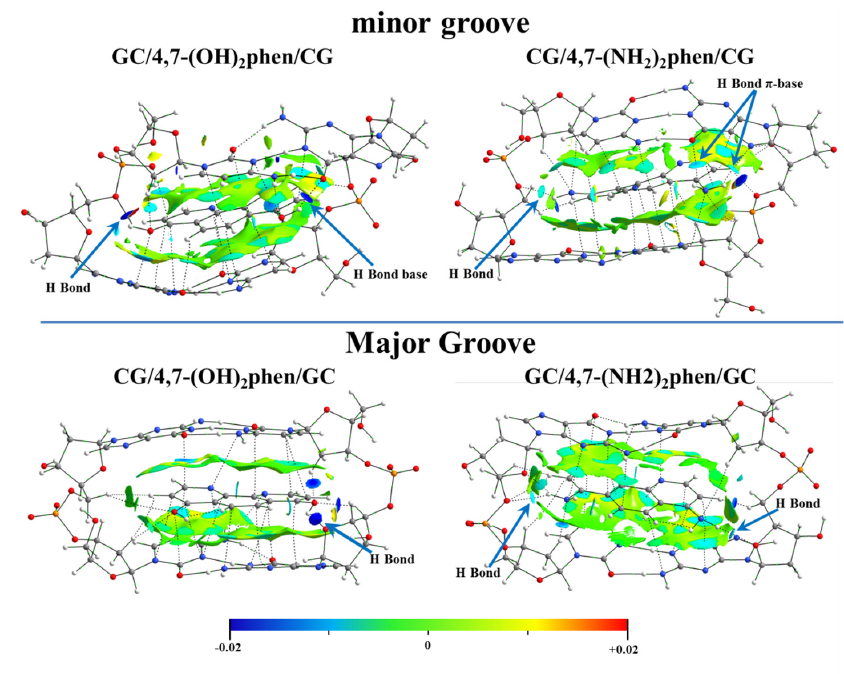
Figure 21. NCI isosurfaces for 4,7-(OH) 2 phen and 4,7-(NH 2 ) 2 phen ligands intercalated in GCCG bps through the mg and via MG, by considering ring models, at M06-2X/6-31+G(d,p) level. The NCI analysis also helped to compare the two considered intercalators, 4,7- (OH) 2 phen and 4,7-(NH 2 ) 2 phen, the main difference being that the -OH groups tended to form stronger hydrogen bonds (more negative value for the NCI index) with the O atoms of the sugar and phosphate backbone than the -NH 2 groups, even though -NH 2 groups could form two bonds. 3.4. Solvent Effects in the Interaction The solvent effects were studied for the intercalation of phen, 4,7-O 2 phen, 5,6- O 2 phen, 4,7-(NH 2 ) 2 phen and 4,7-(OH) 2 phen in ATTA and GCCG bps and for the interca- lation of 4-Mephen, 5-Mephen, 4,7-Me 2 phen, 5,6-Me 2 phen and 3,4,7,8-Me 4 phen in GCCG bps by means of a continuum model with the COSMO approach. Ref. [87] We observed in all the analyzed cases that, as a general trend, the ∆ E Solv solvation penalty (defined as ∆ E Solv = E Solv (total system) − [ E Solv (intercalator) + E Solv (pocket)]) ranged from 6.1 kcal mol − 1 for the 4,7-(NH 2 ) 2 phen ligand to 26.8 kcal mol − 1 for the 4,7-(OH) 2 phen ligand the former inter- calating in the ATTA bps via mg and the latter intercalating in the GCCG bps through the MG for the sandwich models. In the case of the ring models the ∆ E Solv ranged from 8.6 kcal mol − 1 for the (GC/phen/CG)mg system to 35.0 kcal mol − 1 for the (GC/4,7- (OH) 2 phen/CG)mg system. Thus, the ∆ E Solv penalty was more important for the ring mod- els as a general trend. Moreover, when solvent effects were considered, the energy order was switched and the order in ∆ E aq (defined as ∆ E aq = ∆ E Solv + ∆ E int ) was different from that of the ∆ E int . Thus, the inclusion of solvent effects drastically changed the stabilization and could reverse its order. 3.5. Metal Complexes Including Phen and the Important Effect of the Ancillary Ligands Since the strongest hydrogen bonds were formed between the intercalator and the sugar and phosphate backbone, it is clear that the ring model is necessary to study com- plexes with coligands, which may act as acceptors and donors in hydrogen bonds. Thus, the sandwich model and the former three-body models used in the seminal works of Bondarev